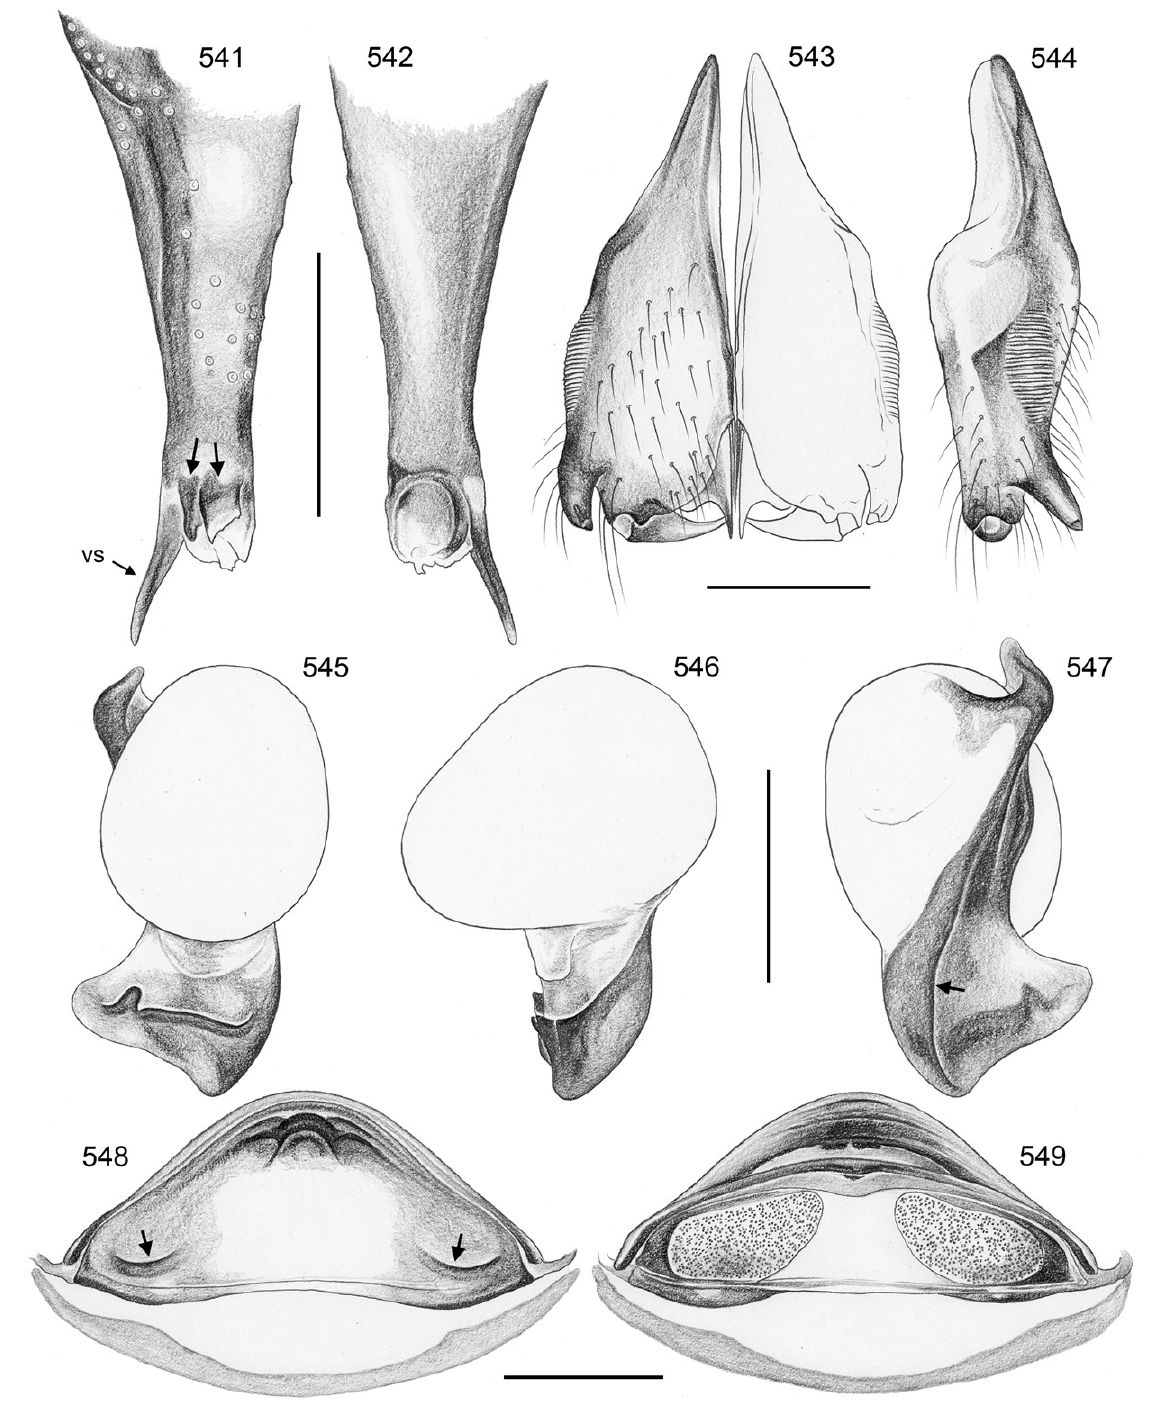
Figs 541–549. Crossopriza ibnsinai sp. nov.; male and female from Uzbekistan, near Dzhyra-Kuduk (SZMN). 541–542 . Left procursus, prolateral and retrolateral views; arrows: distinctive prolateral sclerites. 543–544 . Male chelicerae, frontal and lateral views. 545–547 . Left genital bulb, prolateral, dorsal, and retrolateral views; arrow: retrolateral ridge. 548–549 . Cleared female genitalia, ventral and dorsal views; arrows: pockets. Abbreviation: vs = ventral sclerite. Scale bars = 0.3